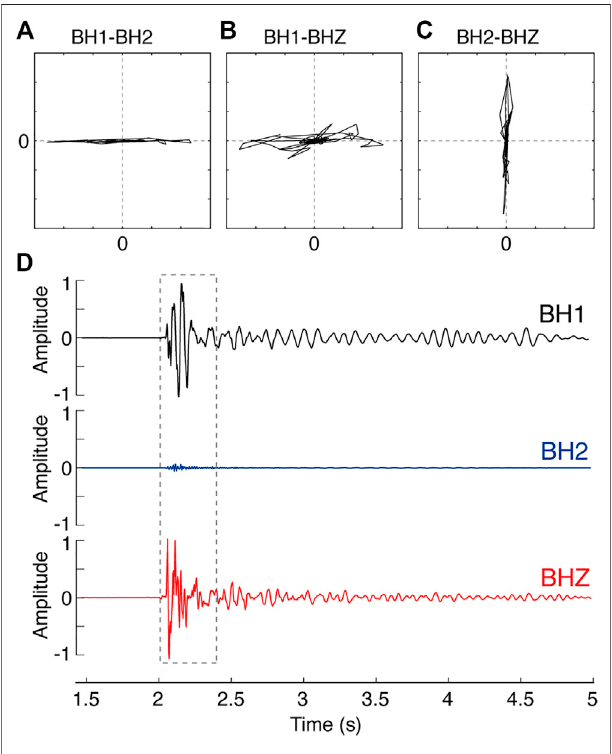
FIGURE 4 | Hodograms (A – C) and waveform (D) of the trace with an offset of 1,499 m for OBS station C22. The plotted time window of the hodogram is denoted as the gray dashed rectangle in (D) .